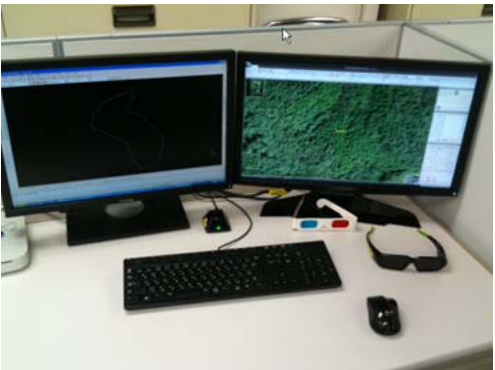
Figure1. Hardware configuration using the NVIDIA 3D Vision (using dual LCD)